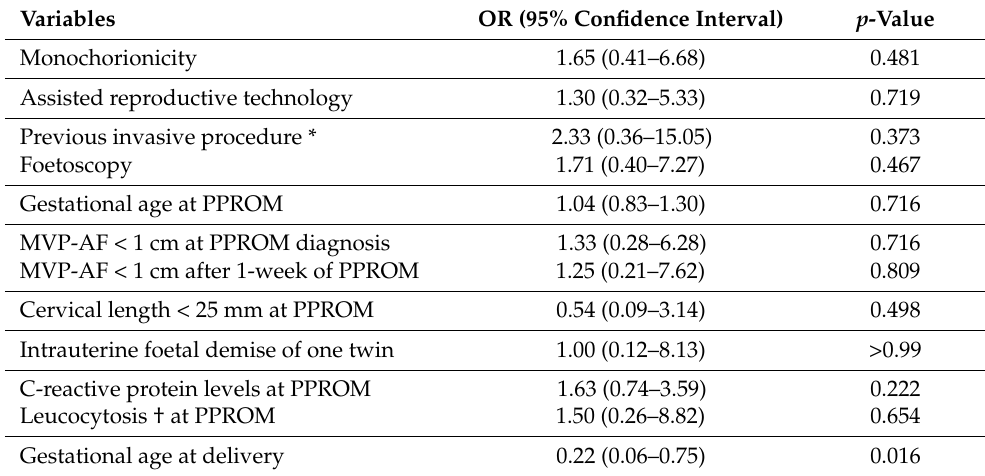
Table 3. Univariate analysis of factors associated with perinatal mortality.